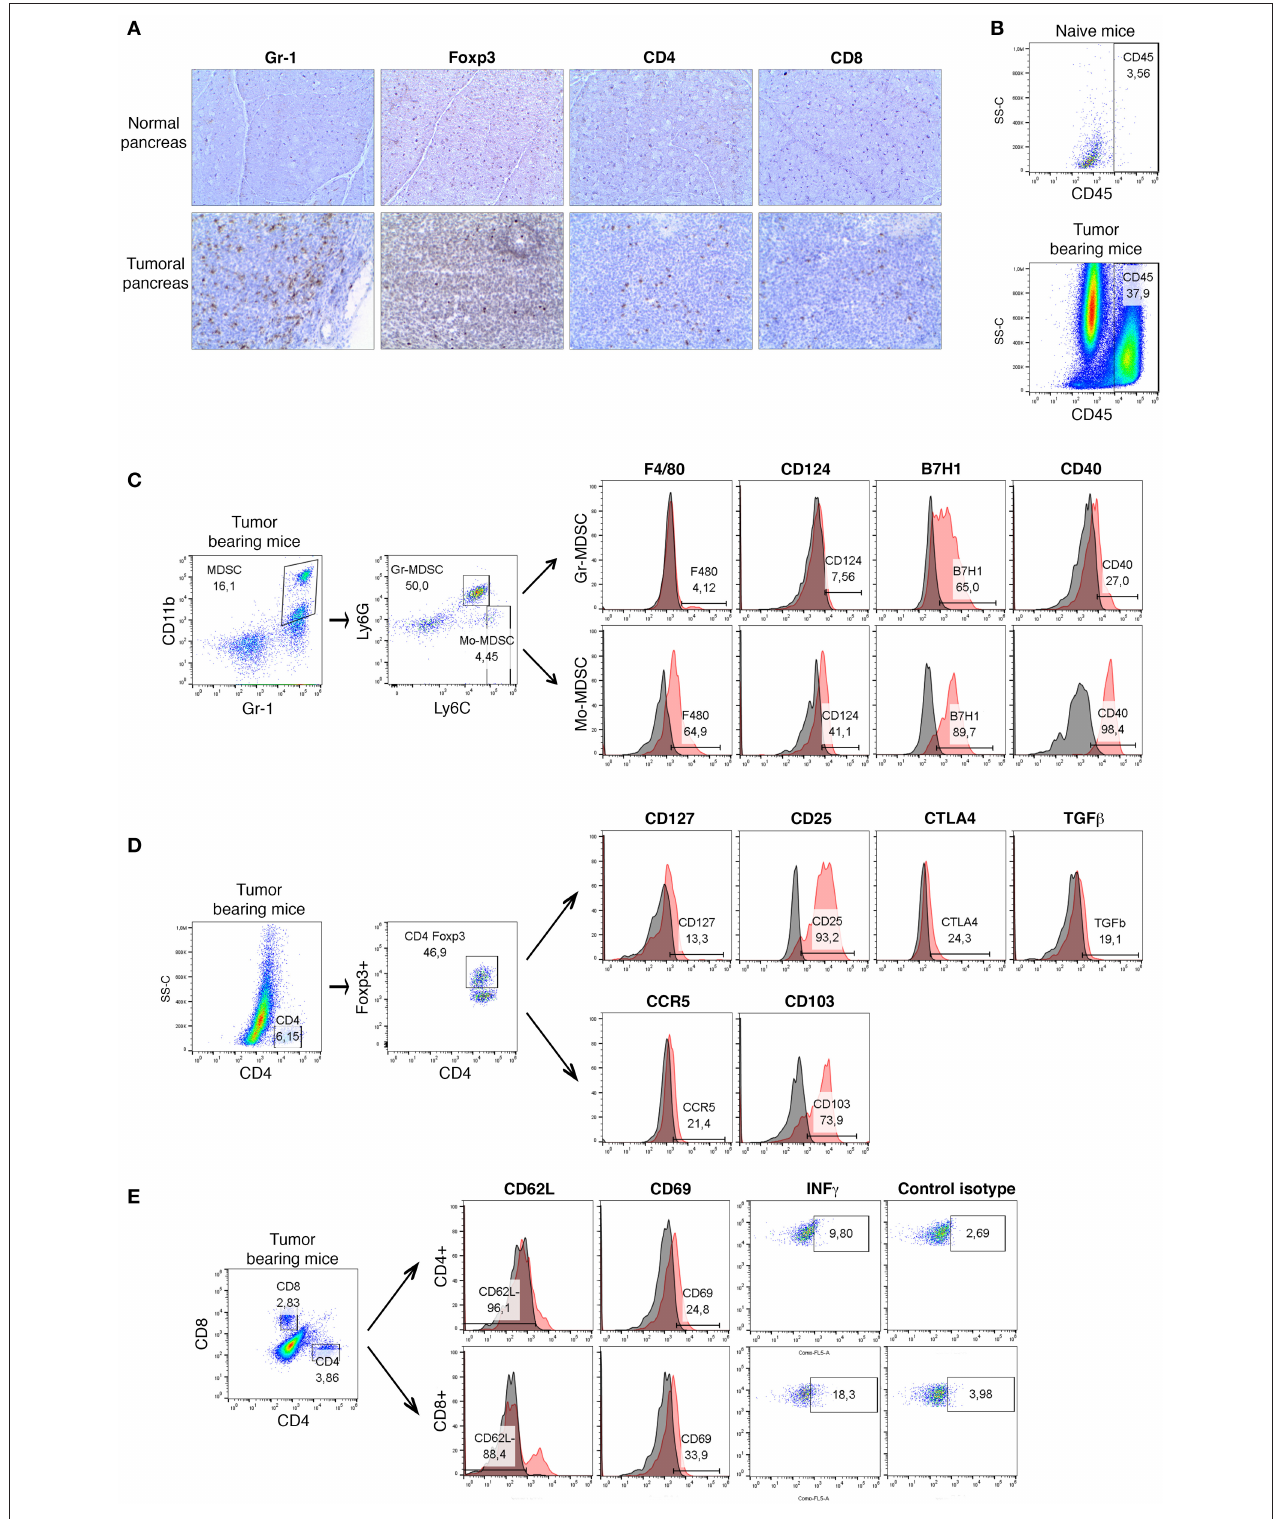
FIGURE 1 | A detailed phenotypical analysis of the immune cell populations in orthotopic mouse model of pancreatic cancer. Panc02 cells were injected in the pancreas of C57BL/6 mice ( n = 5) and tumors were harvested 3 weeks post- inoculation. (A) Representative IHC analysis of Gr-1 (granulocytes), CD4, CD8, and Foxp3 (regulatory T cells) on normal pancreas ( n = 3) and on pancreatic tumor ( n = 5) frozen sections. Original magnification x100. Flow cytometry analysis (B) of